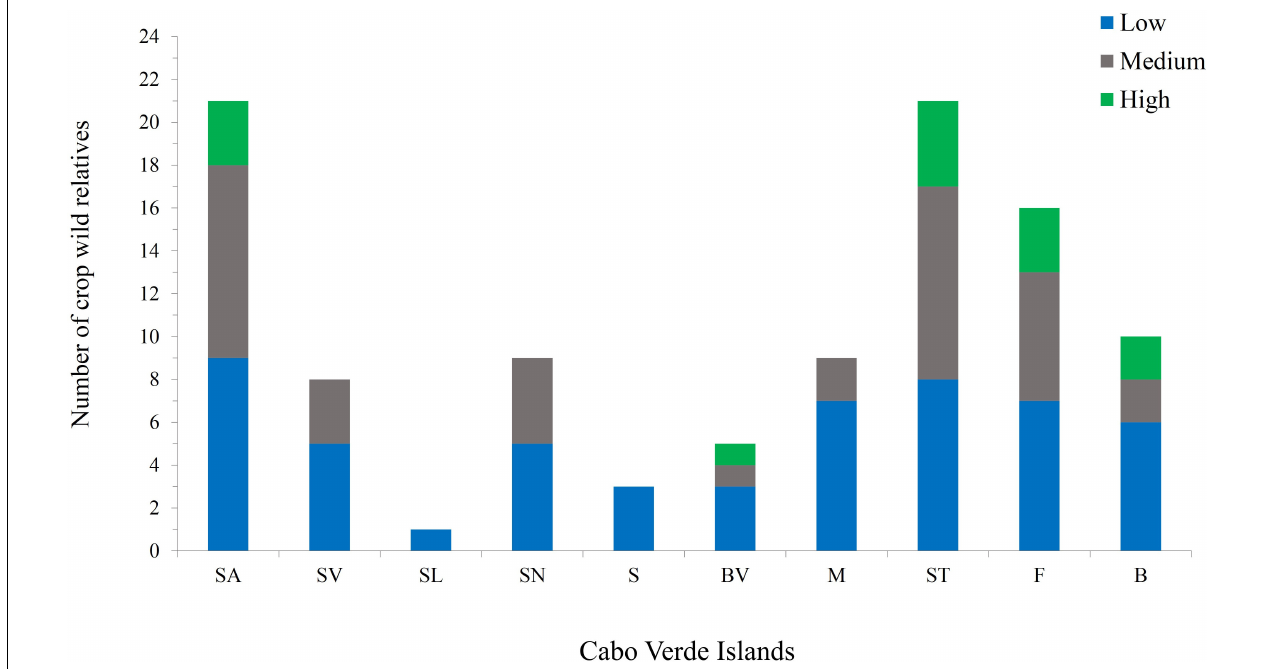
FIGURE 4 | Number of priority CWR Poaceae species per island and their priority categories; total CWR for Cabo Verde archipelago is 26. Different colors represent different priority categories: green – highest; gray – medium; blue – low. Island abbreviations: SA, Santo Antão; SV, São Vicente; SL, Santa Luzia; SN, São Nicolau; S, Sal; BV, Boavista; M, Maio; ST, Santiago; F, Fogo; B, Brava.